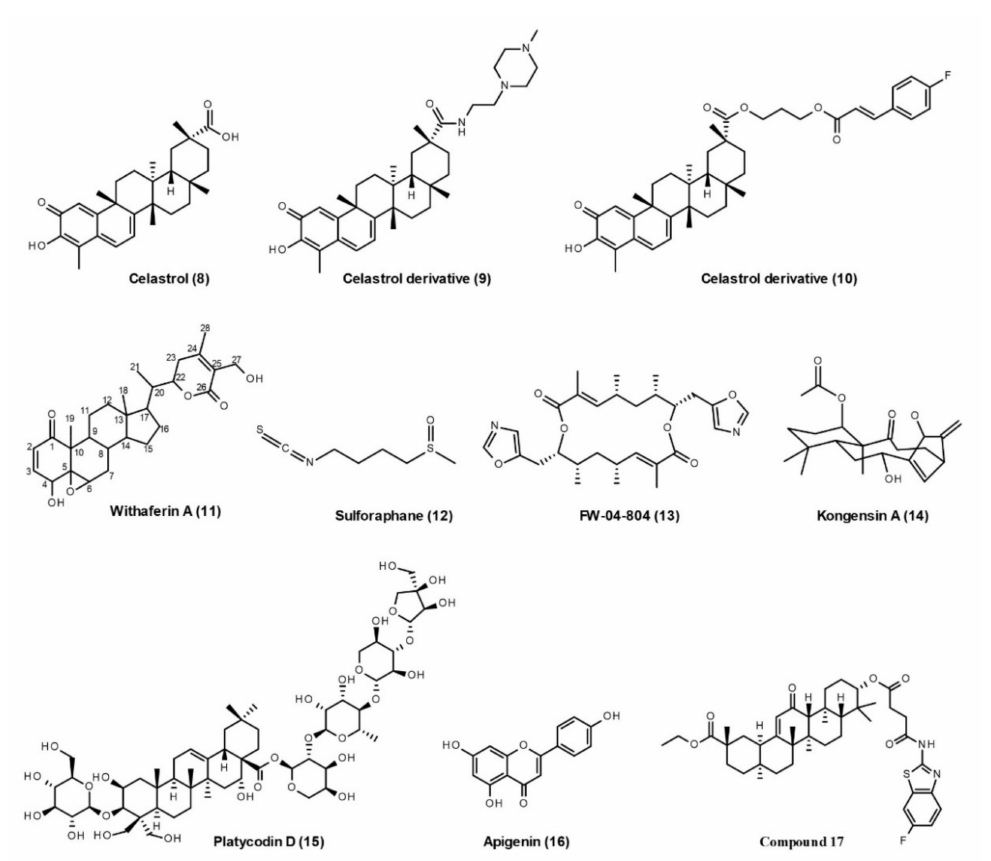
Figure 4. Natural products and their derivatives with the ability to disrupt Hsp90–Cdc37